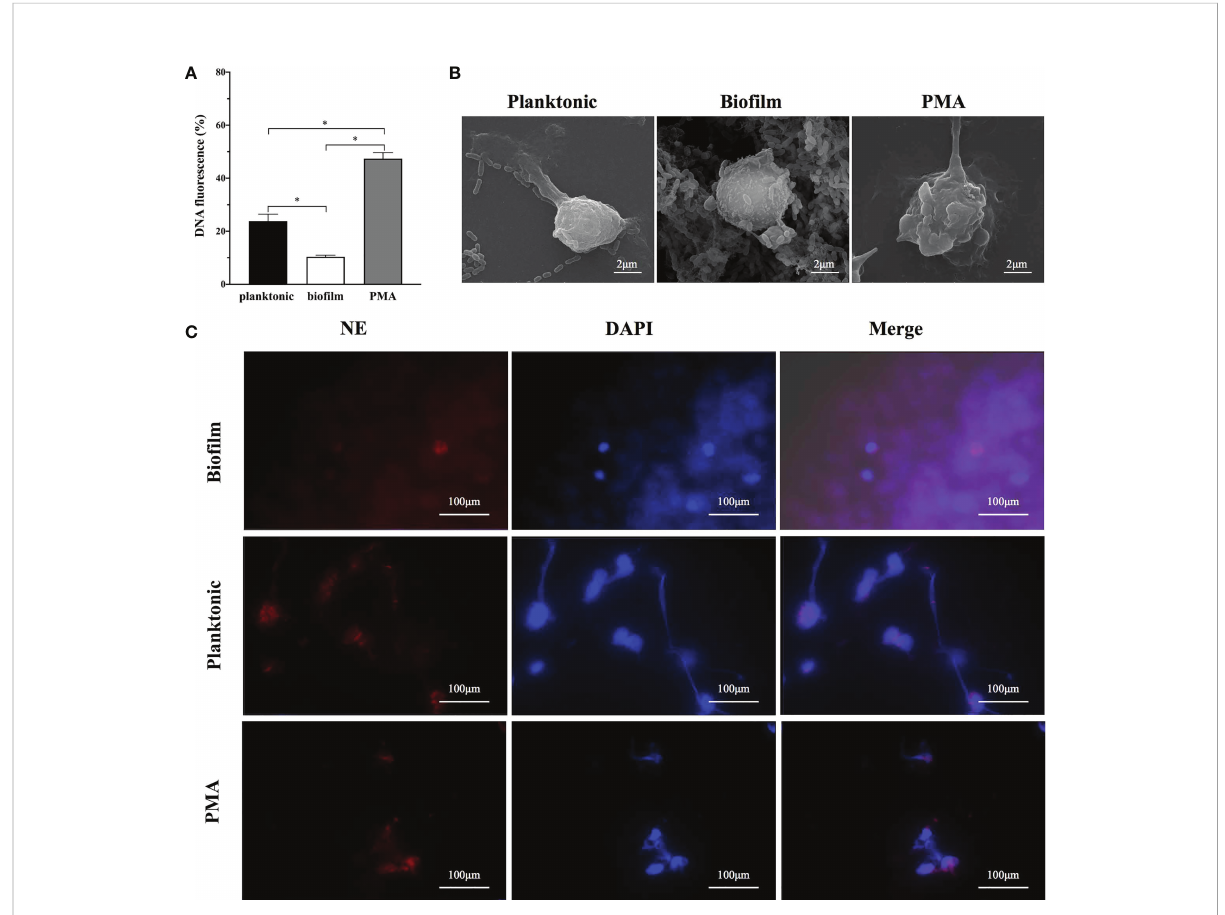
FIGURE 1 The capability of NETs releases according to different lifestyles of S. mutans . (A) Planktonic and bio fi lm S. mutans were co-cultured with neutrophils for 4h and NETs release was estimated by Sytox green assay. PMA was employed as the positive control. After 4h incubation, the fl uorescence reached at 23 and 10% of the total DNA when stimulated with planktonic and bio fi lm S. mutans respectively. Data were depicted as mean ± SD (n=6). Statistical analysis was performed using a Student ’ s t-test with p <0.05. *p<0.05 (B) Representative scanning electron microscopy image of neutrophils after 4 h co-culture with S. mutans bio fi lm and its planktonic counterpart. A web-like structure of NETs coating the planktonic S. mutans was observed. In contrast, neutrophils exposed to bio fi lm showed no signi fi cant morphological changes, with no extruding web-like structure (scale bar: 2 m m). (C) Visualization of NETs formation by immuno fl uorescence imaging. Neutrophils